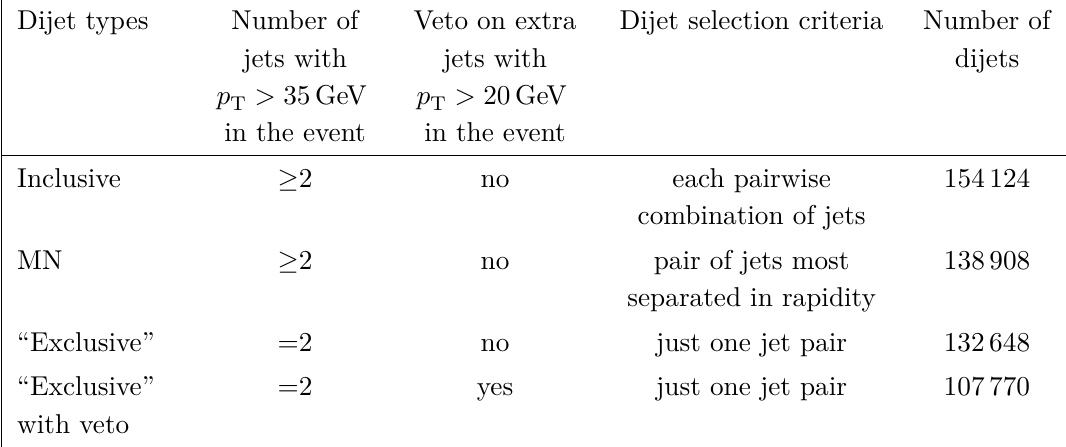
Table 1 . Event definitions for cross section